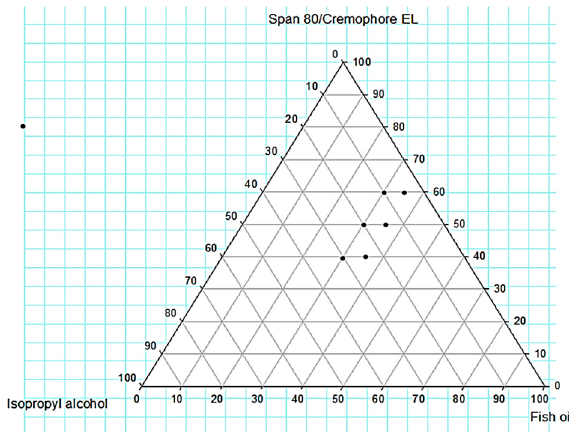
Figure 3. Pseudo-ternary phase diagrams of SNEDD of different compositions of the selected System (FO, span 80/cremophor EL and isopropyl alcohol).